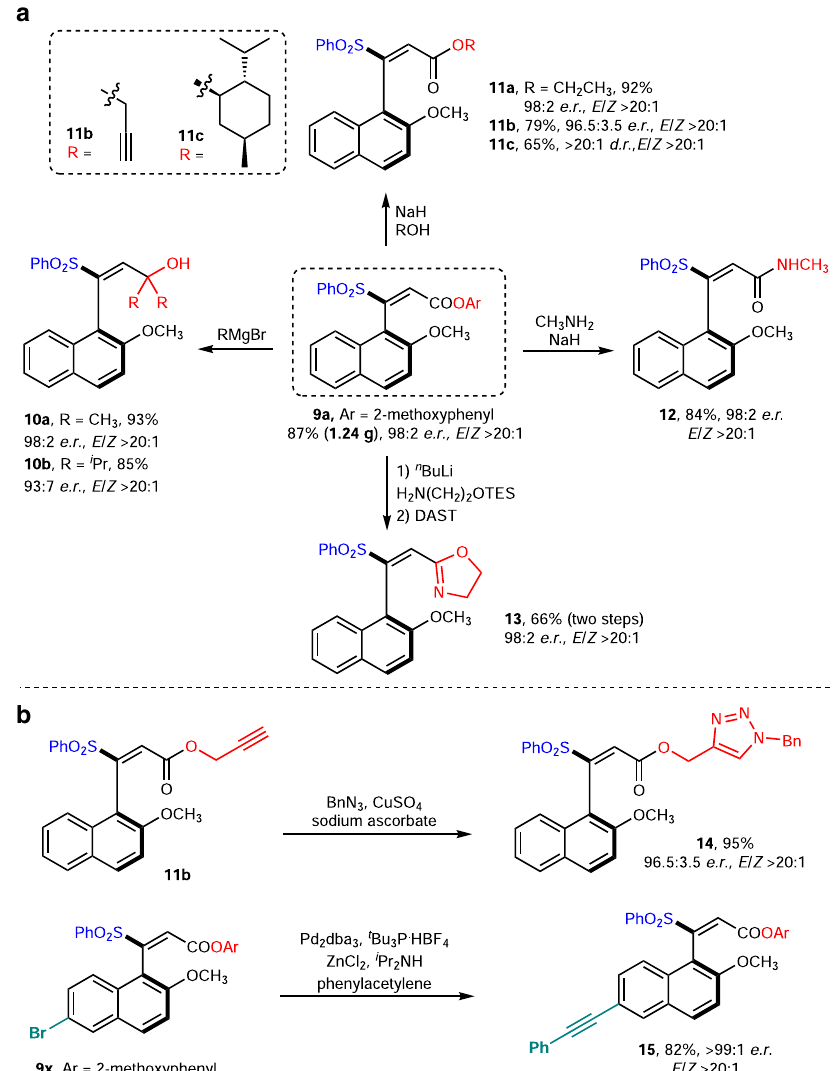
Fig. 4 Versatile chemical transformations of the axially chiral products. a Synthetic transformations of the axially chiral product ( 9a ) based on ester group. b Synthetic transformations of 11b and 9x